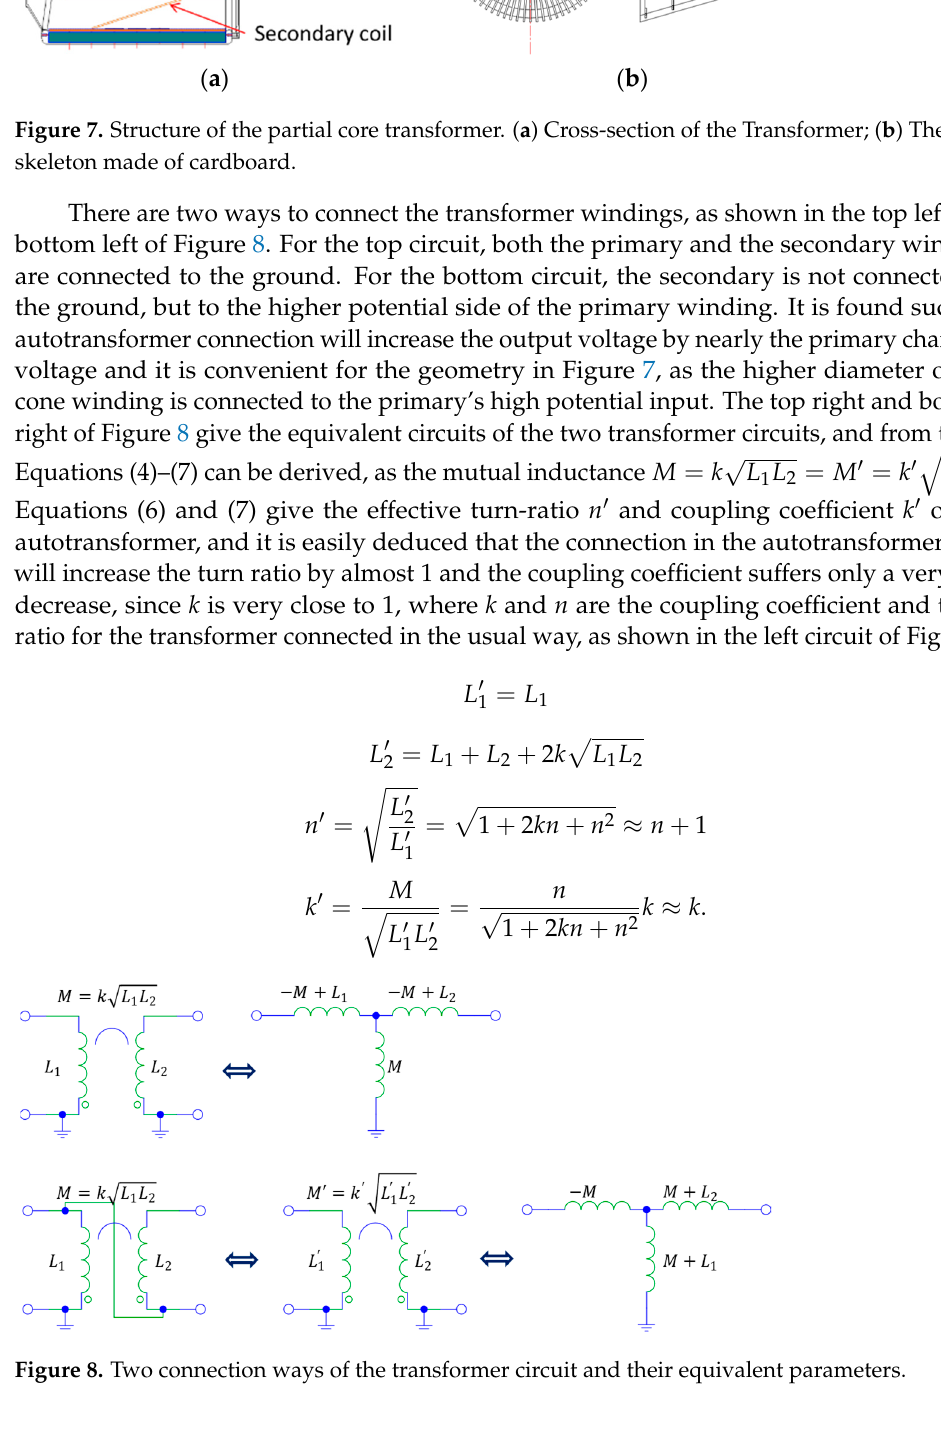
Figure 8. Two connection ways of the transformer circuit and their equivalent parameters.